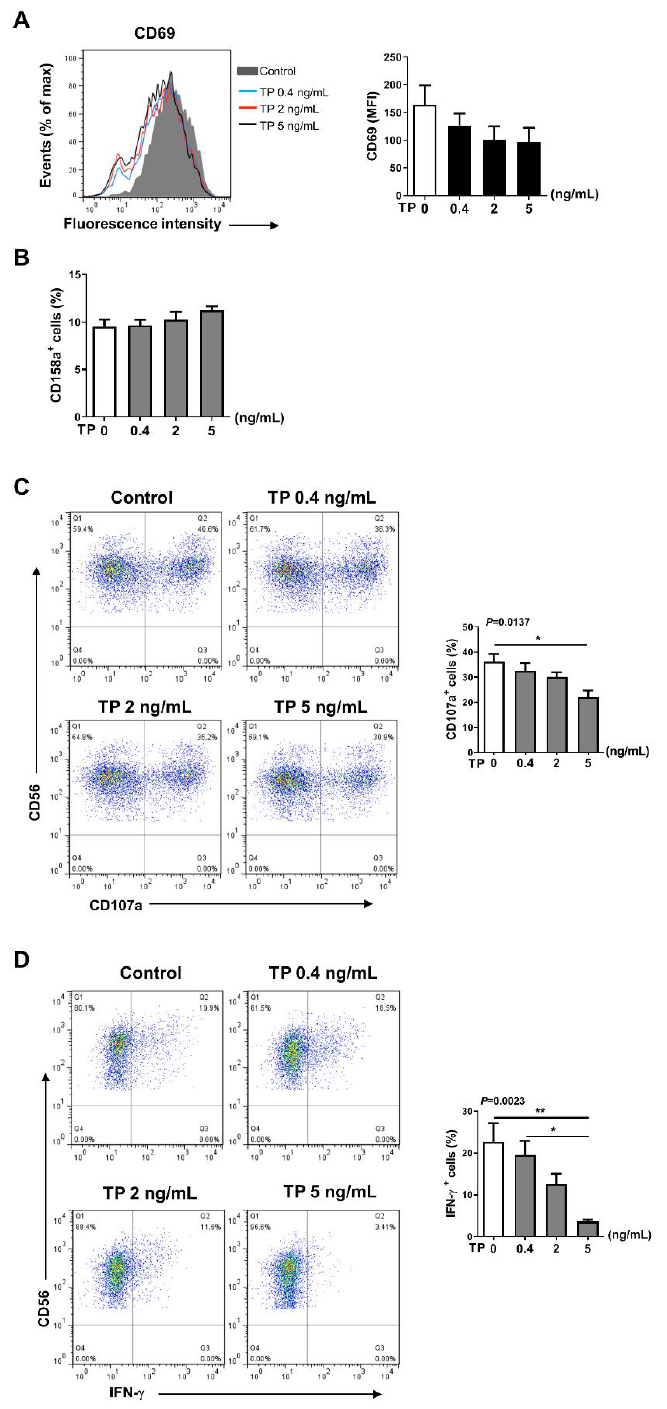
Figure 2. Effects of TP on the phenotype and function of NK cells in human PBMCs. Human PBMCs from health donors were treated with TP as shown (i.e., 0, 0.4, 2, and 5 ng/mL) for 24 h. ( A , B ) The expression of CD69 ( A ) and CD158a ( B ) were detected by flow cytometry in CD56+CD3−cells. ( C ) PBMCs were further co-cultured with K562 cells at a ratio of 2:1 (PBMC:K562 = 2:1), flow cytometry analysis of CD107a expression was car ried out on CD56+CD3−cells. ( D ) The